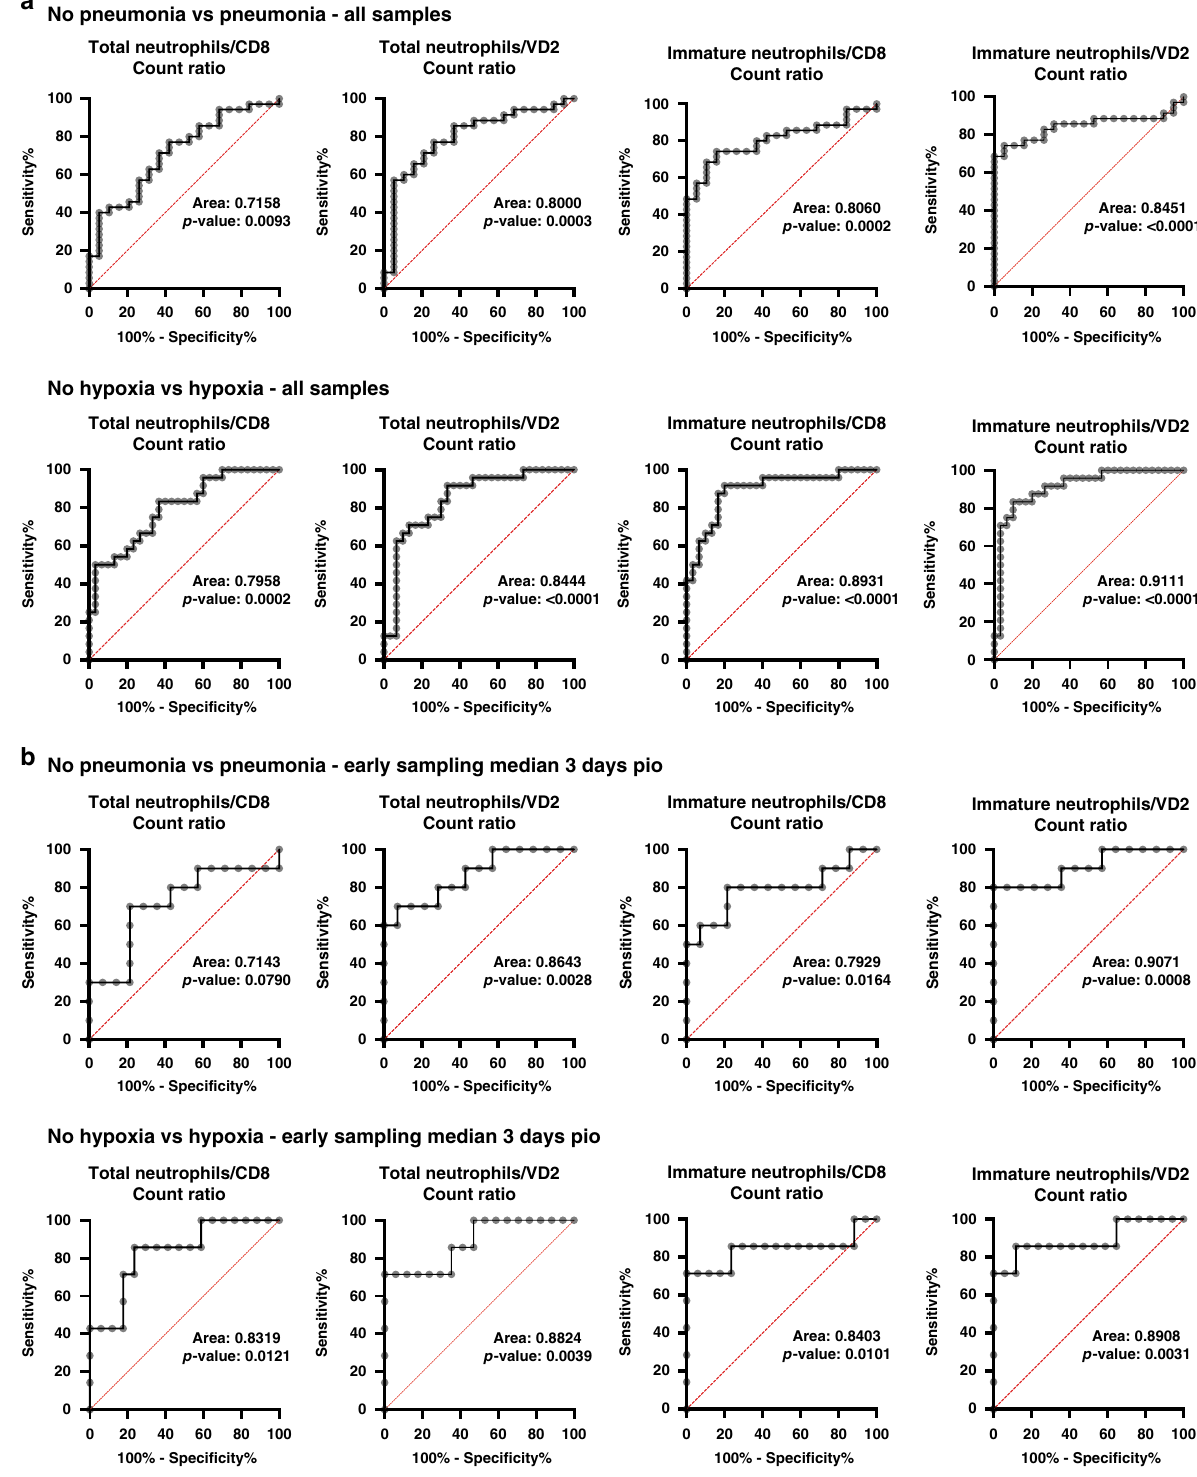
Fig. 5 Immature neutrophil to VD2 T-cell ratio is an early prognosis marker for pneumonia and hypoxia symptoms. a ROC curve analysis comparison was performed for pneumonia and hypoxia symptoms between absolute counts of total neutrophils to CD8 T-cell ratio, total neutrophils to VD2 T-cell, immature neutrophils to CD8 T-cell ratio, and immature neutrophils to VD2 T-cell ratio, n = 54 individual acute COVID-19 patient samples. b Similar analysis was performed on a subset of early samples from the 54 acute patients ( n = 24 individual acute COVID-19 patients following the criteria: sampled at 1 to 7 days pio. Median of this subset is 3 days pio). ROC curve was analysed using Wilson/Brown method, 95% con fi dence interval and standard error for panel A are given in Supplementary Data 1 and for panel B are given in Table 1. Data available in source data fi